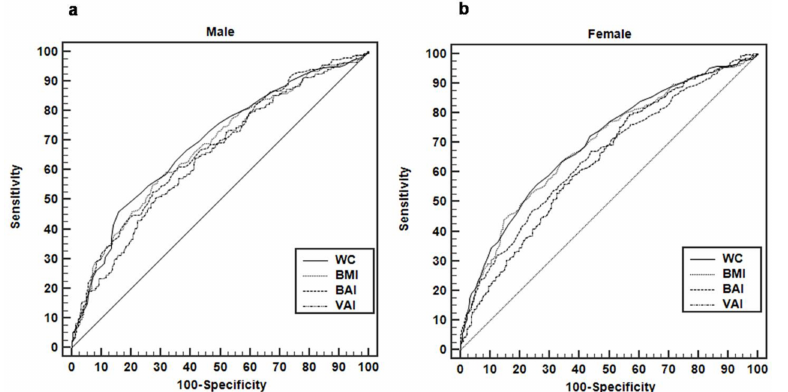
Fig 1. Discriminatory power of anthropometric indicators of adiposity in the hypertension screening in a Brazilian population. Area under the ROC curve (AUC): (a) male and (b) female. WC, waist circumference; BMI, body mass index; BAI, body adiposityindex; VAI, visceral adiposityindex. The AUC, cutoffs, sensitivity and specificity values are shown in Table 2.